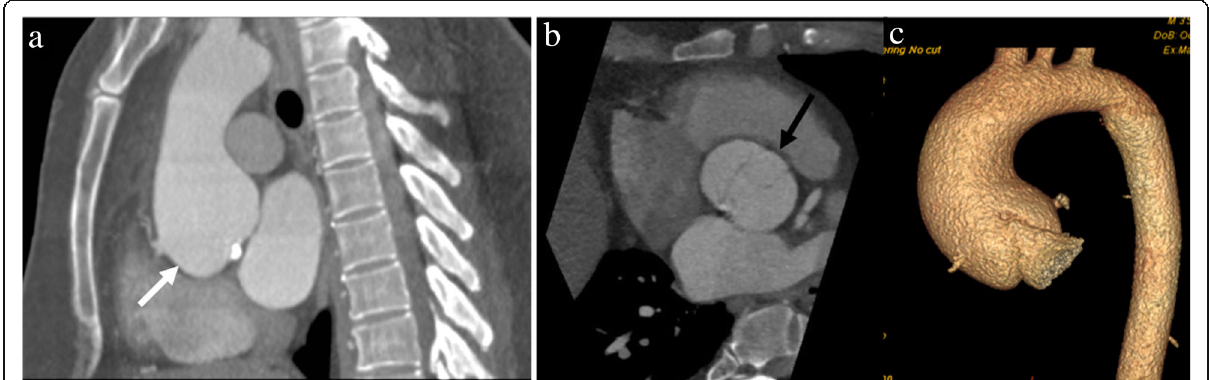
Fig. 5 A 43-year-old man with Marfan syndrome and bicuspid aortic valve: sagittal ( a ) and axial ( b ) CTA images shows aortic root aneurysm with dilatation centered at the sinuses of Valsalva (white arrow in a ) with effacement of the sinotubular junction and normal caliber ascending aorta and bicuspid aortic valve (black arrow in b ). A “ tulip-shaped ” configuration of the aortic root is better appreciated on the volume rendered image ( c )